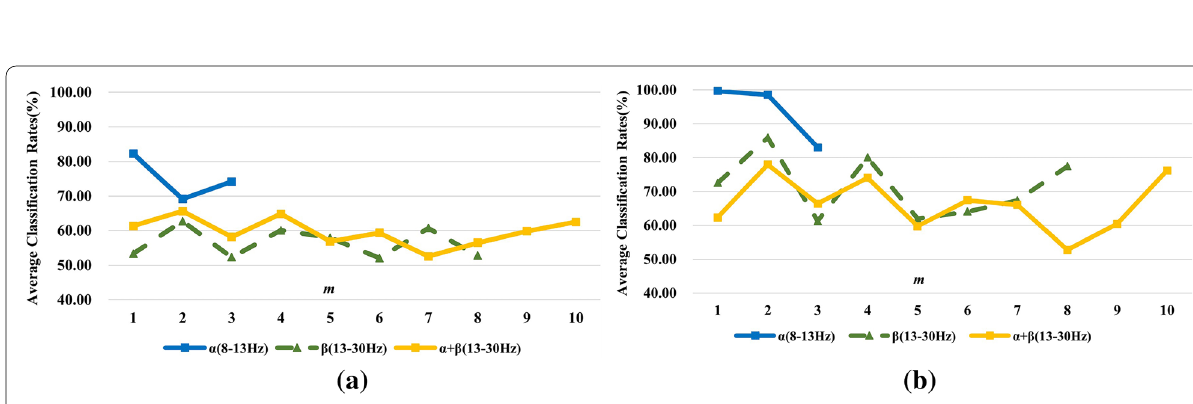
β band; b β 1 and β 2 band +